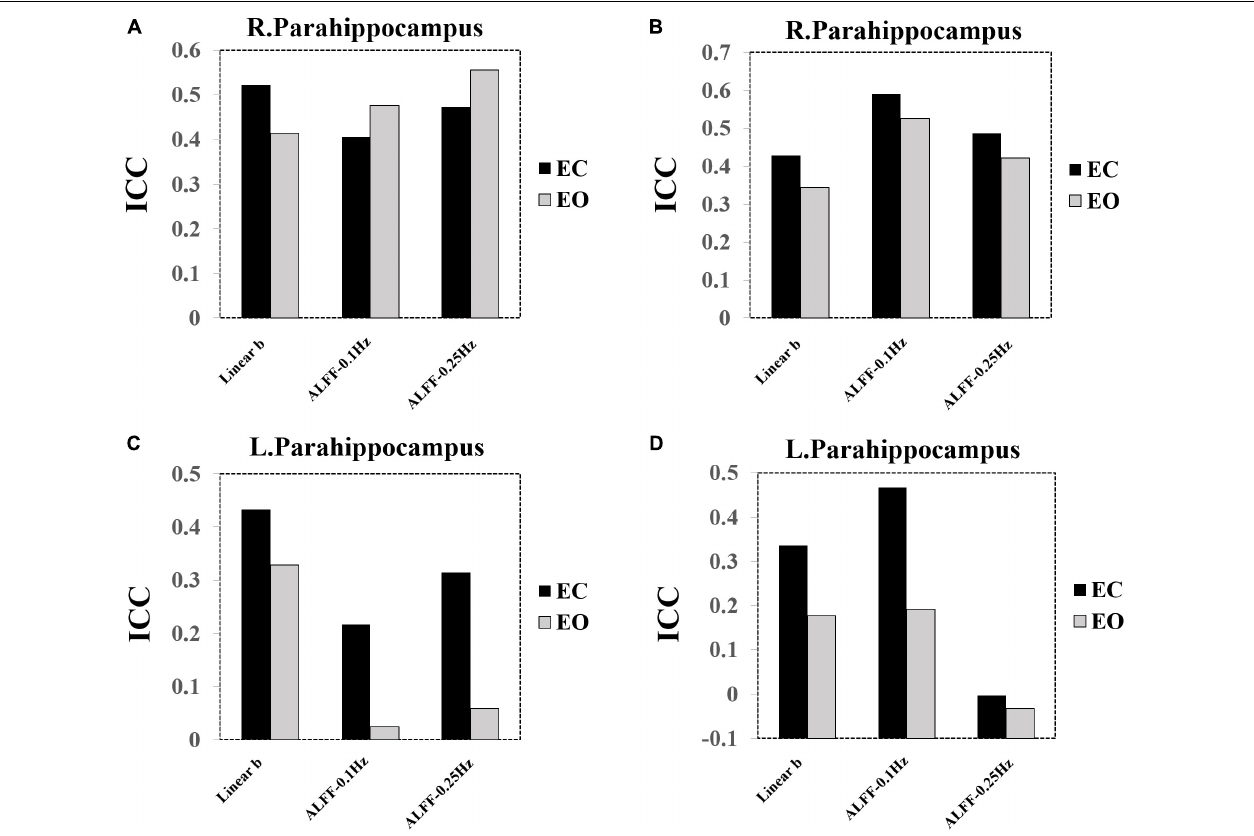
FIGURE 14 | ICC bar plots of the bilateral parahippocampus. (A) ICC value of the right parahippocampus using group Z-transformation. (B) ICC value of the right parahippocampus using individual Z-transformation. (C) ICC value of the left parahippocampus using group Z-transformation. (D) ICC value of the left parahippocampus using individual